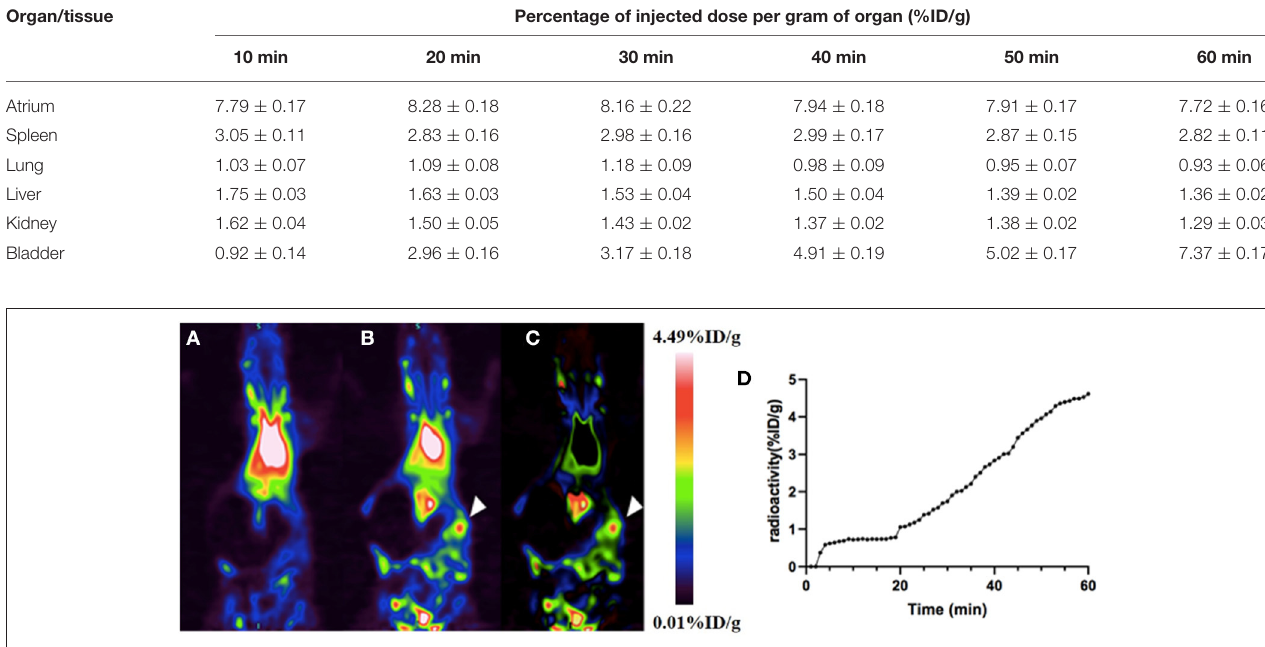
TABLE 1 | Biodistribution of 18 F-VS-RBCs at 60min after injection in normal rats ( n = 5/group). Organ/tissue